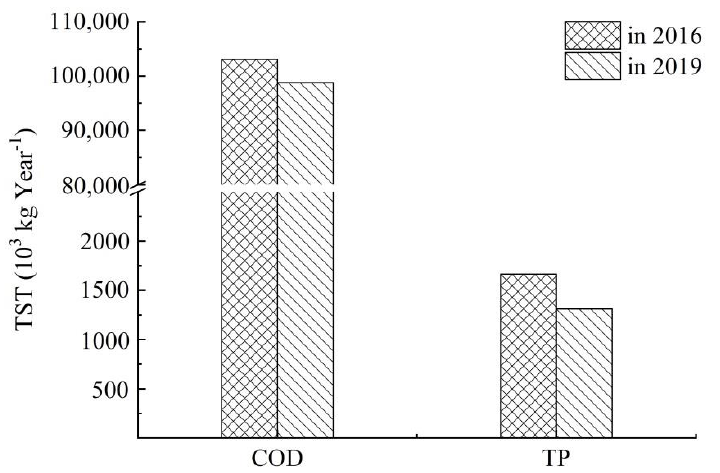
Figure 4. TST analysis results in 2016 and 2019 for